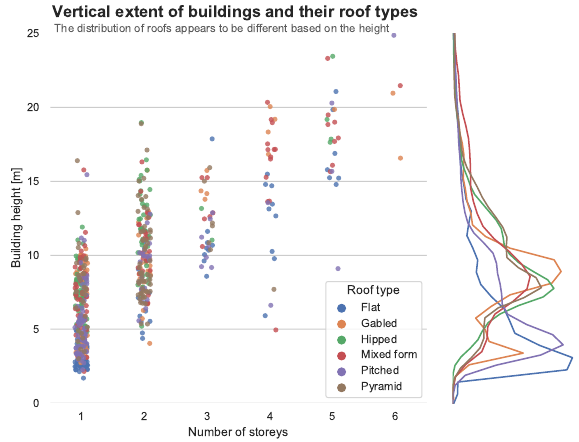
Figure 5. The vertical extent of the building part gives an indica- tion of the roof type. The plot shows a 0.1% random subset.